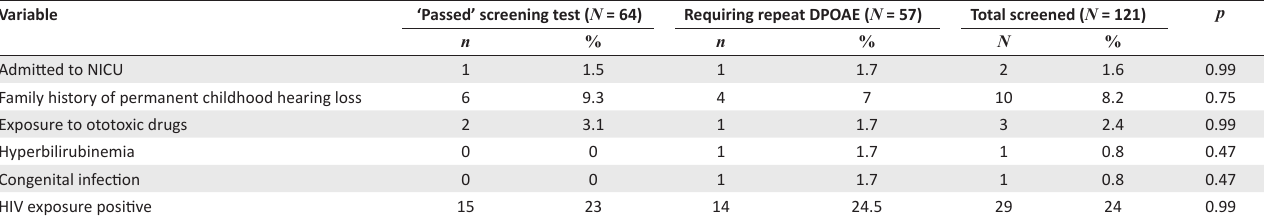
TABLE 1: Outcome groups on initial distortion product otoacoustic emissions screening and recorded risk factors.